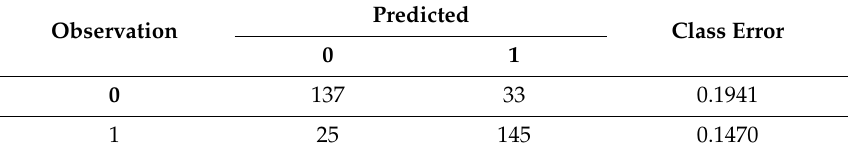
Table 3. Confusion matrix of the random forest (RF) model (0 = no gully, 1 = gully).